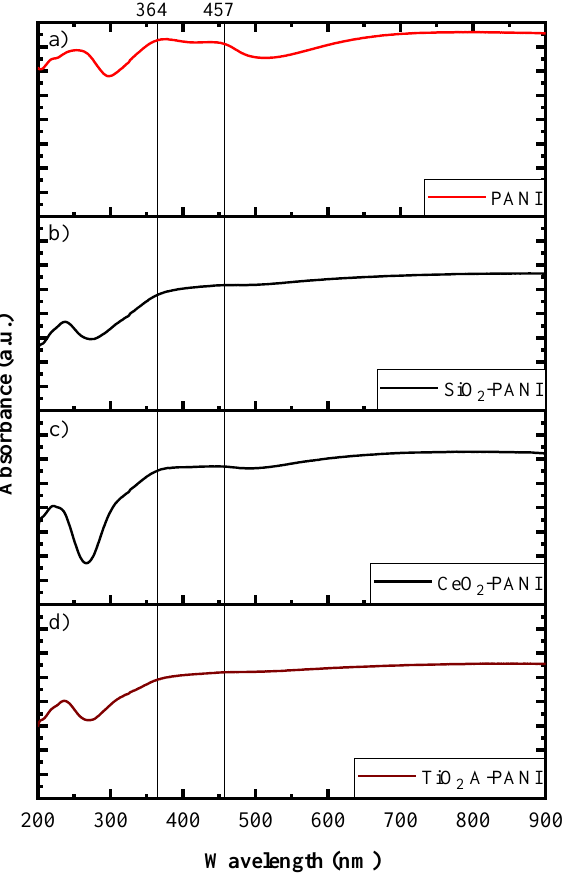
Figure 6. UV-vis spectra for ( a ) PANI and nanocomposites of ( b ) SiO 2 -PANI, ( c ) CeO 2 -PANI, and ( d ) TiO 2 A-PANI.